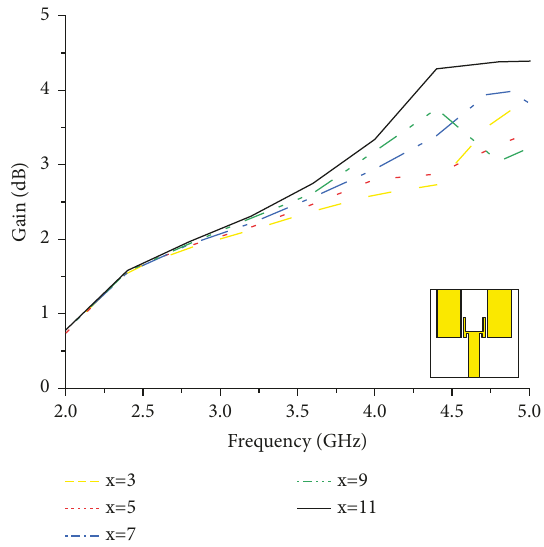
Figure 8: Variation of the gain for different width of the parasitic element on the patch ( x